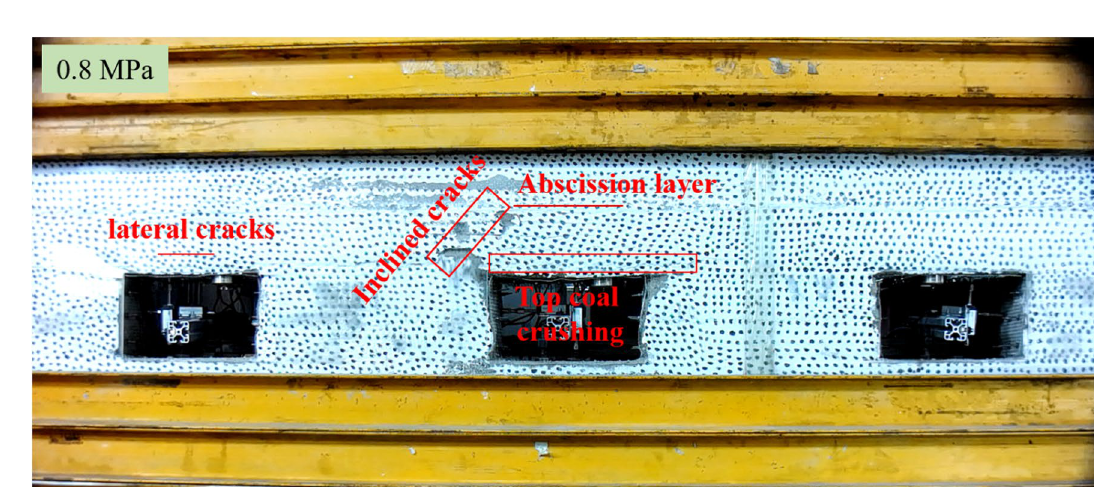
Figure 18. Failure characteristics of surrounding rock of each roadway at a loading pressure of 0.8